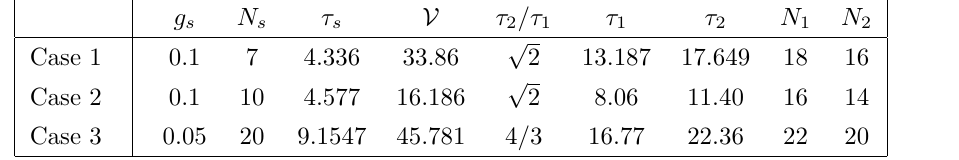
the volume V and the small cycle τ K = W = 1 and χ ( X ) = − 100 , in order to have ˆ ξ = 7 . 66 g − 3 / 2 0 0